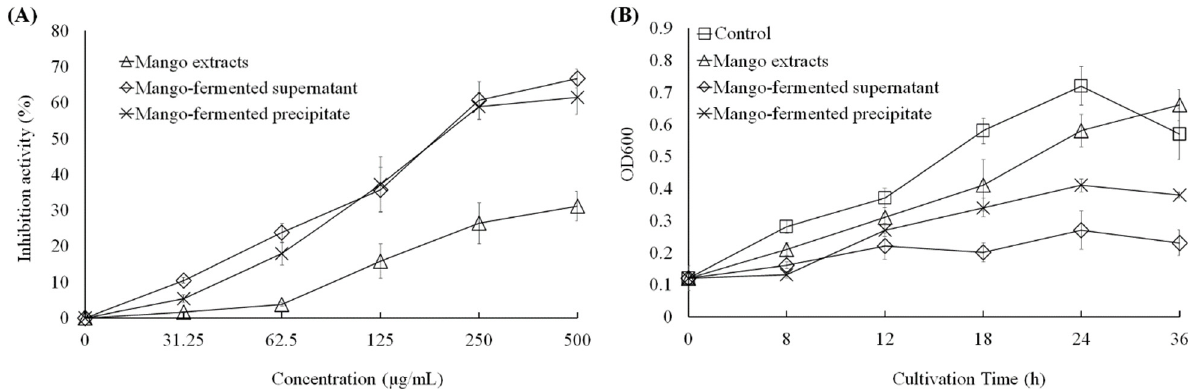
Figure 2. The downregulations of L. acidophilus BCRC14079-fermented mango on the growth of C. difficile in ( A ) dosage- dependent at 24 h treatment and ( B ) time-dependent manners at 250 μ g/mL.